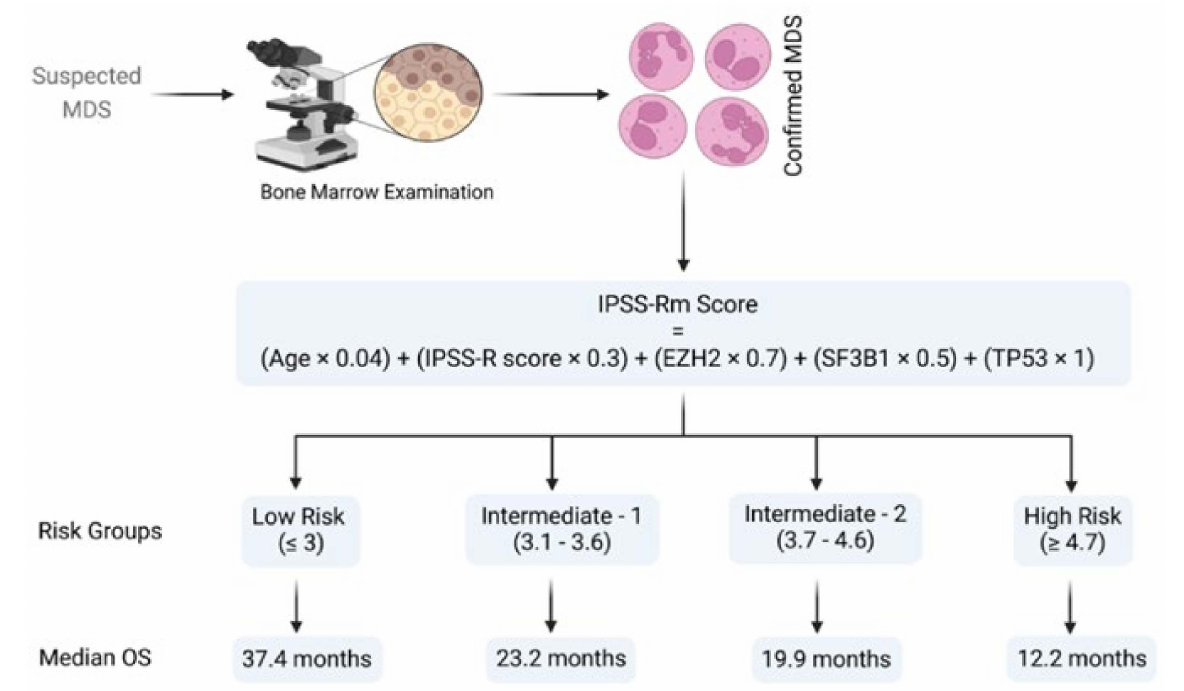
Figure 1. Schematic representation of Nazha’s algorithm [29]. The algorithm refers to the risk group classification and corresponding median overall survival in myelodysplastic syndrome